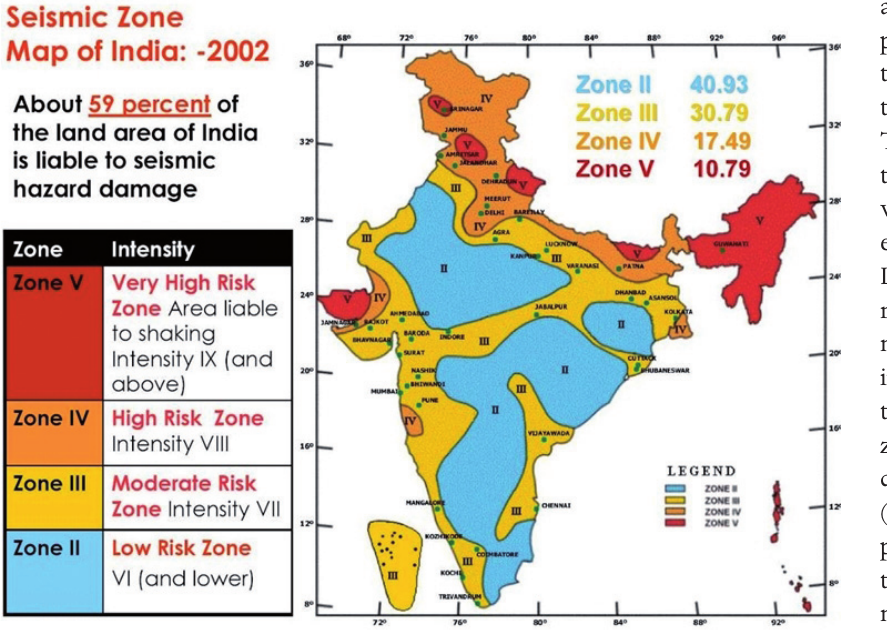
Clockwise from top left: Figure 1. Earthquake damaged buildings being demolished for reconstruction. Figure 2. Meeting with NGOs to define the true situation in the field, and to dispel rumours based on geoscientific knowledge. Figure 3. Meeting with government officials at the State Emergency Operation Centre, to reveal the true situation in the field, and to dispel rumours based on geoscientific knowledge. Figure 4. Macro-seismic zonation map of India, with Sikkim falling in Zone IV (high risk with potential for MSK intensity as high as